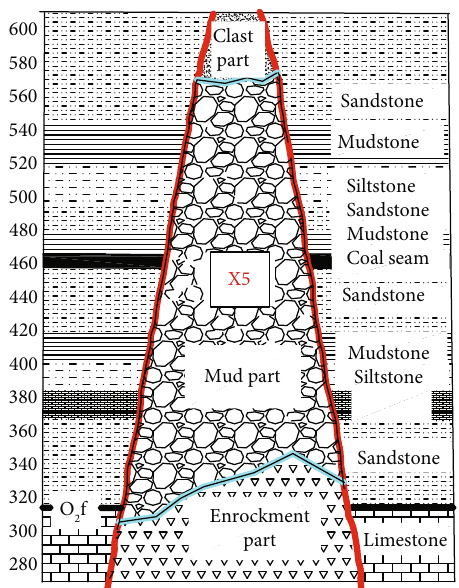
Figure 2: Longitudinal pro fi le of the X5